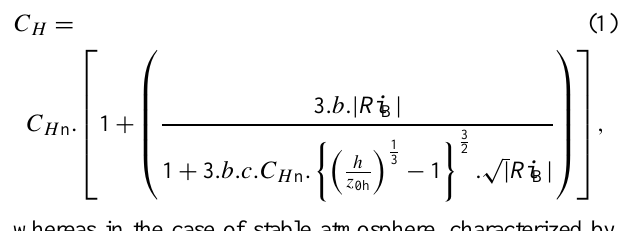
Table 1. Technical details on the HRM configuration used for the present